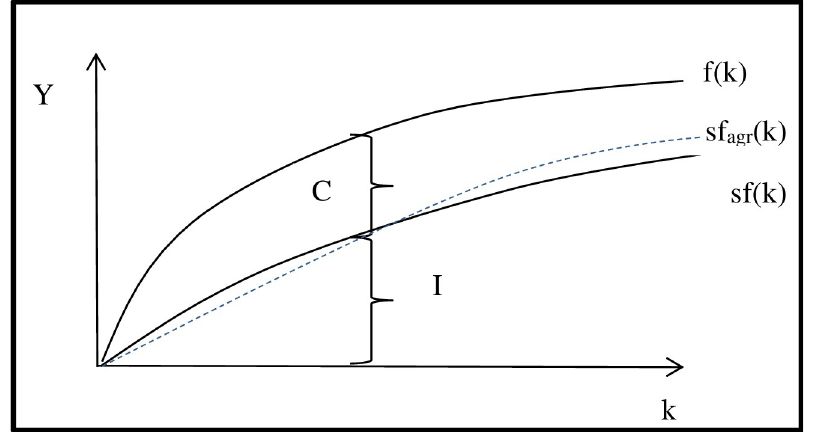
Fig 1. Capital accumulation and growth–The Solow model. Source: based on [14]. S–savings rate, c–consumption, I–investment, k–capital per worker, f agr − accumulation function for agriculture.